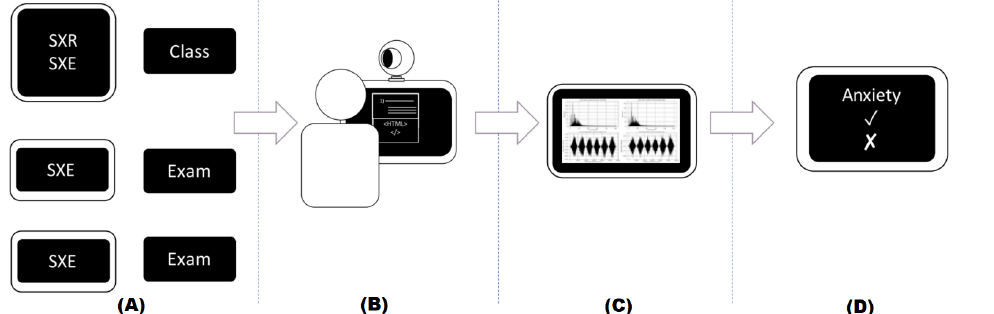
Figure 1. Experimental methodology for identifying academic stress using rPPG and demographic data. ( A ) Define academic stress protocol, ( B ) STAI, student’s profile and video recording in the aca- demic environment, ( C ) Calculate HR signal from video recordings using rPPG, and ( D ) Classification of anxiety level using HR